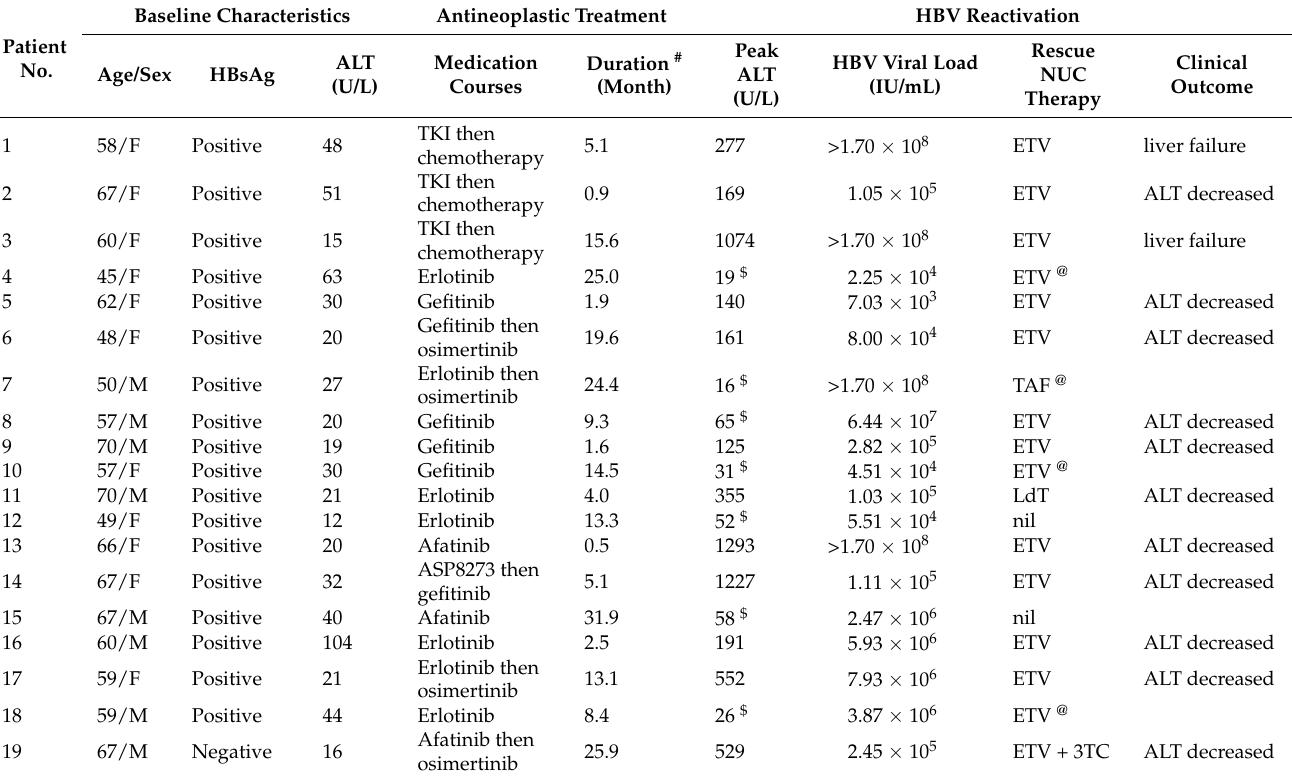
Table 2. Clinical data of patients developing HBV reactivation after systemic anticancer treatment. 3TC, lamivudine; ALT, alanine aminotransferase; ASP8273, an EGFR TKI; ETV, entecavir; LdT, telbivudine; TAF, tenofovir alafenamide; TKI, tyrosine kinase inhibitor. # The treatment duration